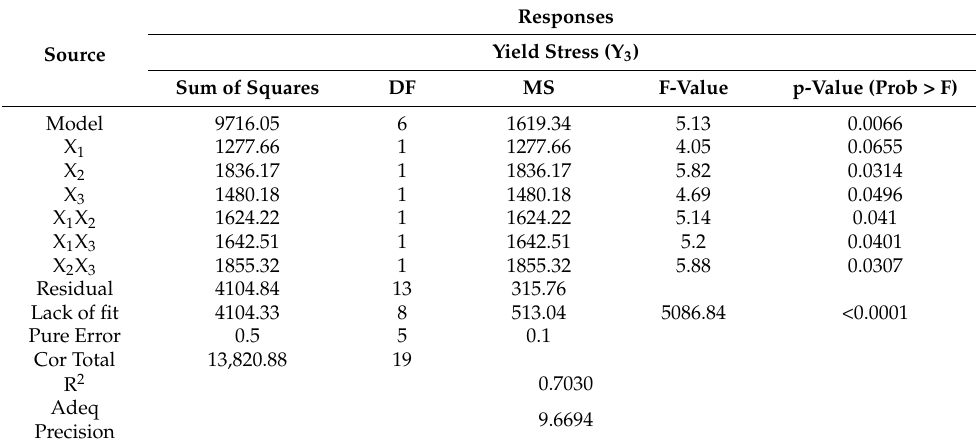
Table 7. Analysis of variance (ANOVA) of the response model of yield stress.